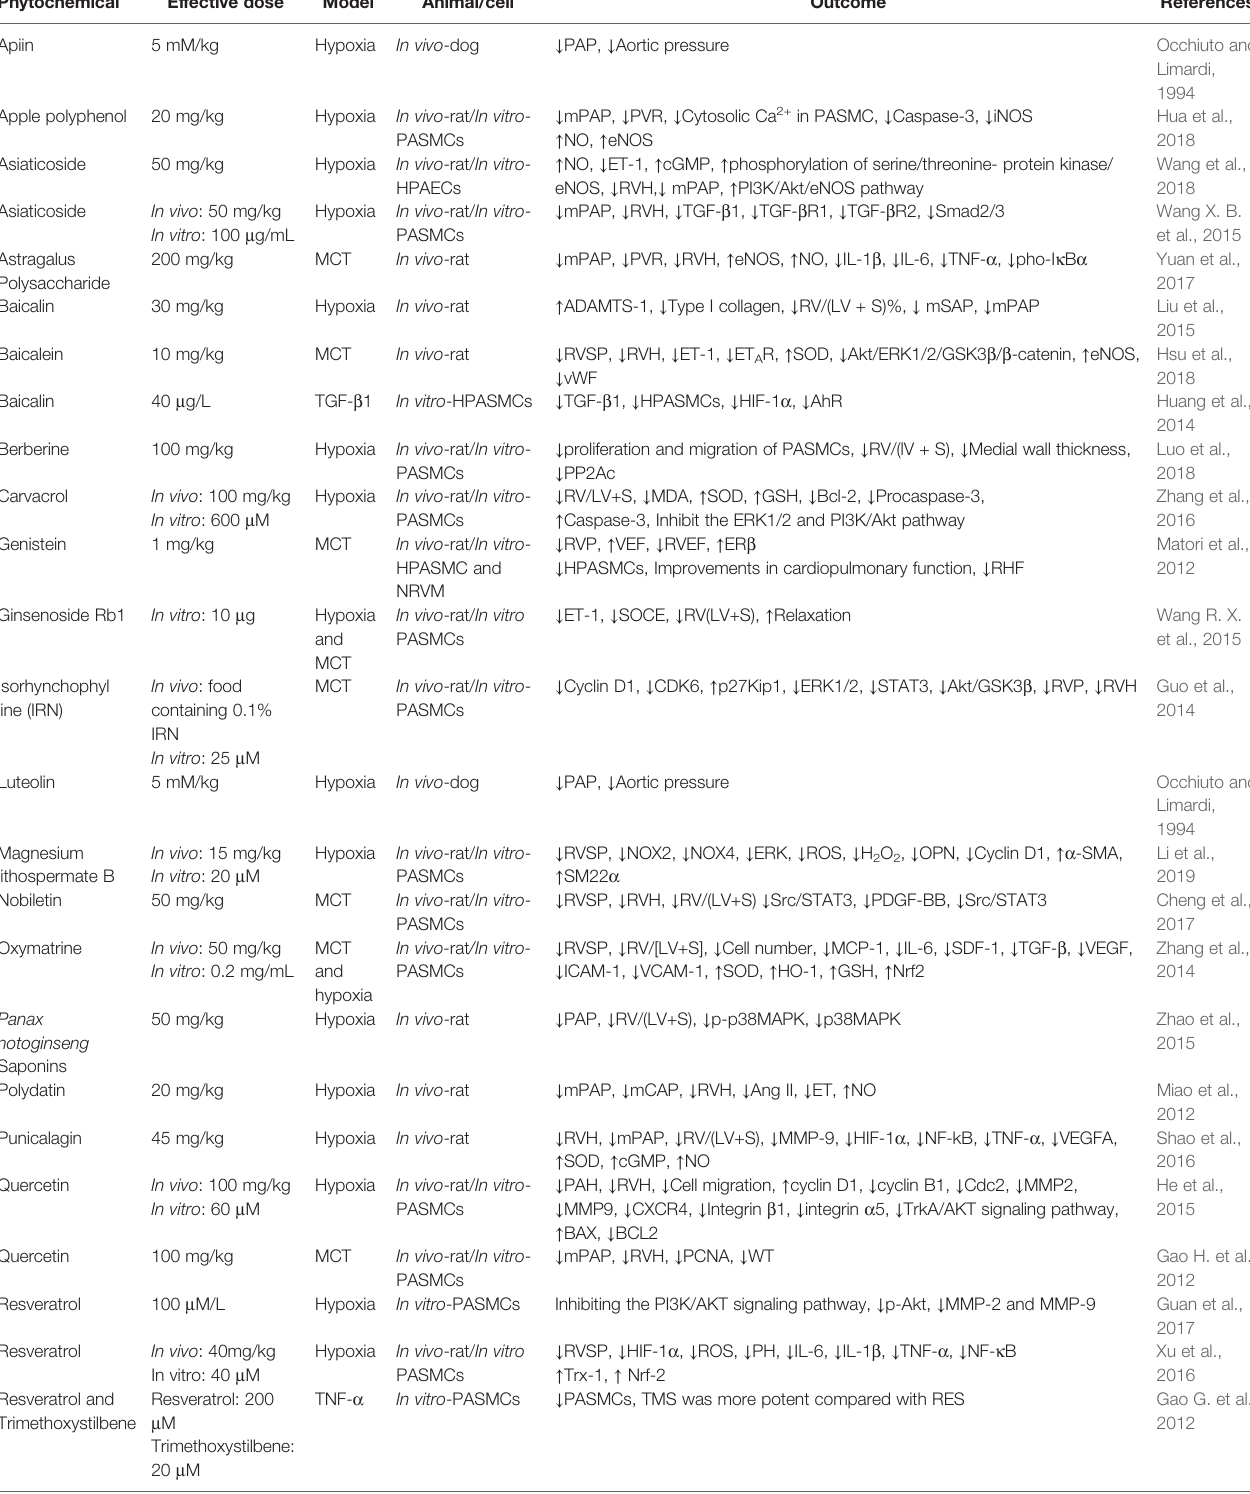
TABLE 2 | Phytochemicals used for Pulmonary Hypertension